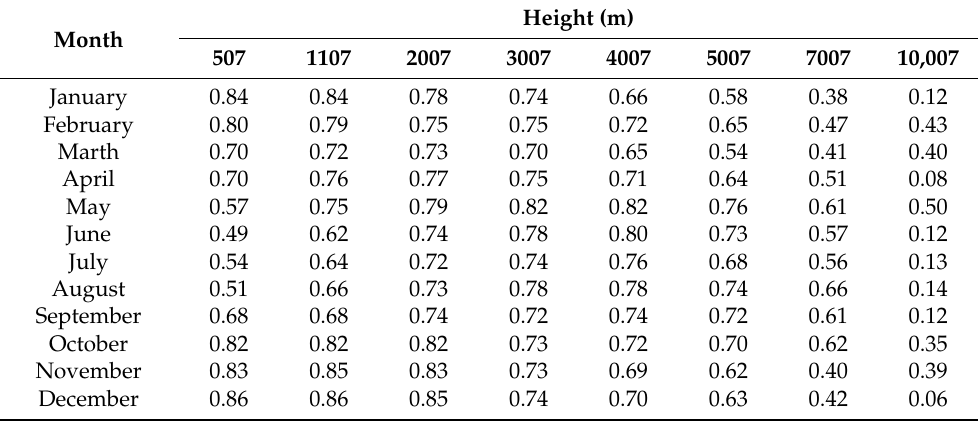
Table A2. Correlation coefficients between zenith wet delay and water vapor pressure of Sanya station at different heights and